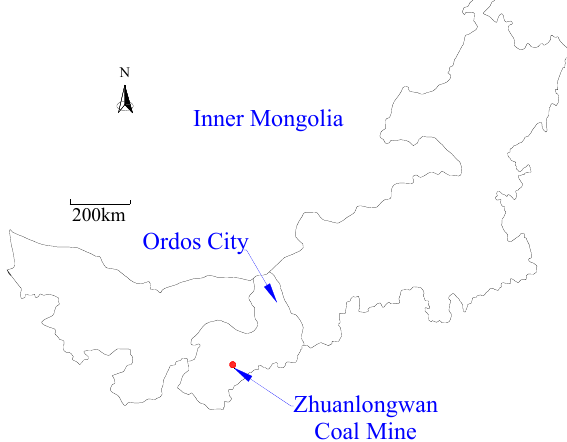
Figure 1. Location of Zhuanlongwan Coal Mine in Inner Mongolia.